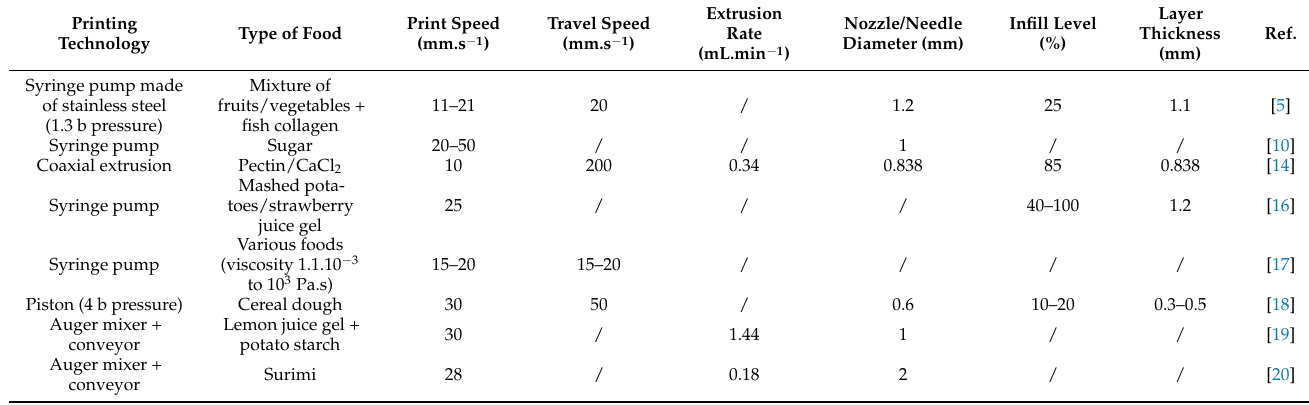
Table 1. Main methods of 3D printing of food products and their associated settings and operating variables. Only studies with numerical data have been